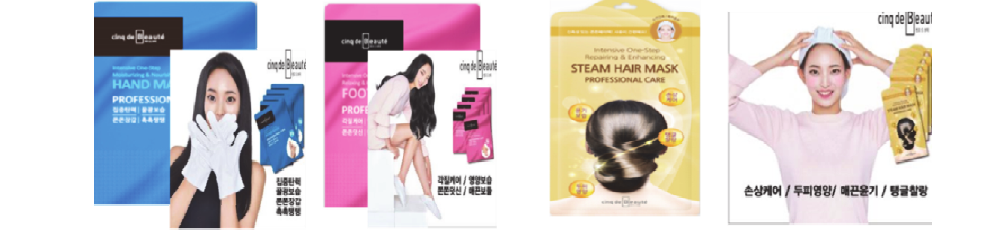
<Figure 13> Hand, Foot and Hair Mask Pack with Elastic Non-Woven